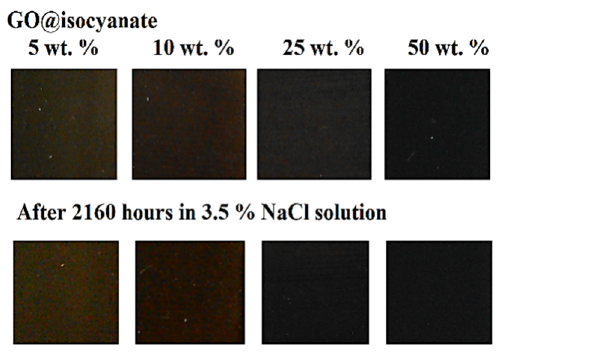
Figure 6. Corrosion measurement in salt water (NaCl 3.5%) of GO@isocyanateand FCNT@isocyanate).